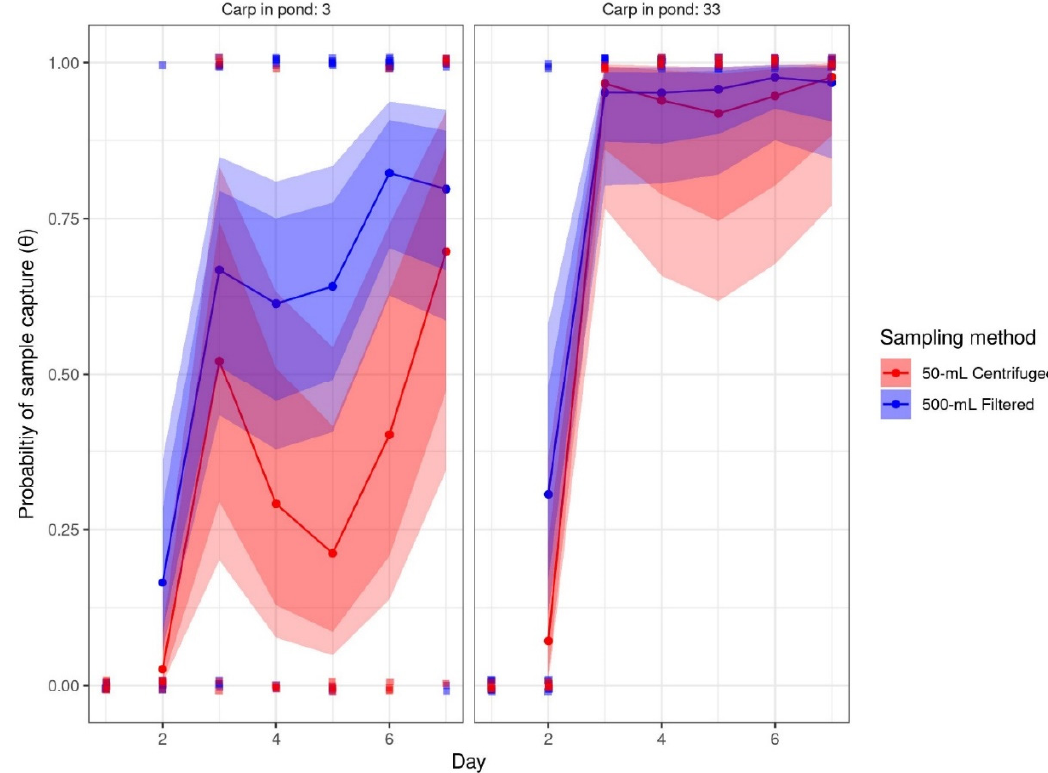
Figure 1. Probability of sample capture ( Θ ) over time. The probability of capturing Grass Carp eDNA within a sample is modeled for each pond using occupancy modeling with 80% credible intervals shown by dark shading and 95% credible intervals shown by light shading. Square points represent individual samples jittered around 0 (did not capture target eDNA) or 1 (did capture target eDNA). Points are jittered randomly to avoid overlap using ggplot2 [71]. The data are color coded by which sampling method was used: red = 50 ‐ mL Centrifuged, blue = 500 ‐ mL Filtered.